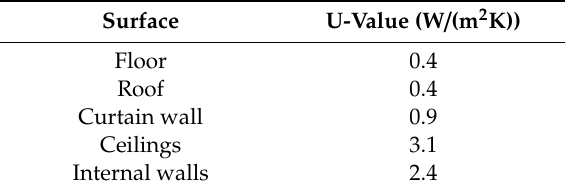
Figure 1. ( a ) The building model as created in SketchUp and ( b ) the top view of the building model. Table 1. The U-values of the building envelope Table 1. The U-values of the building envelope surfaces.